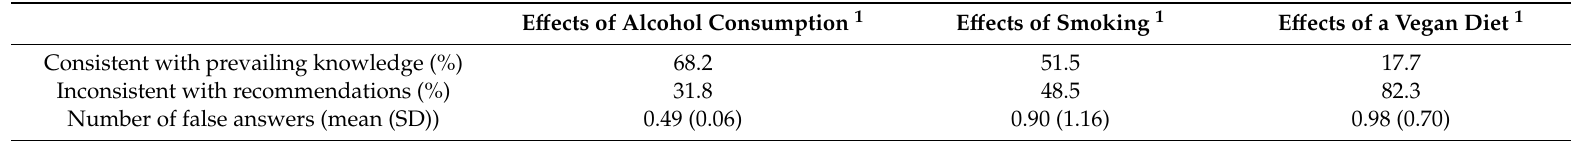
Table 3. Pregnant women’s knowledge of the health e ff ects of alcohol consumption, smoking, and a vegan